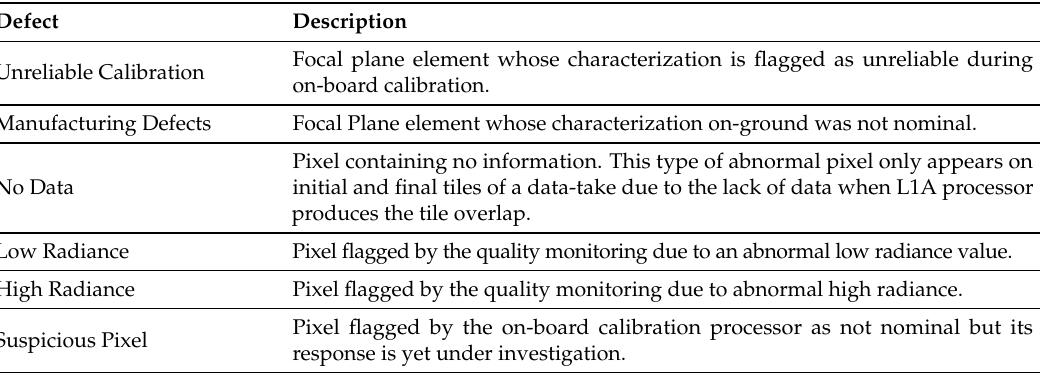
Table 2. Description of the possible abnormal pixel